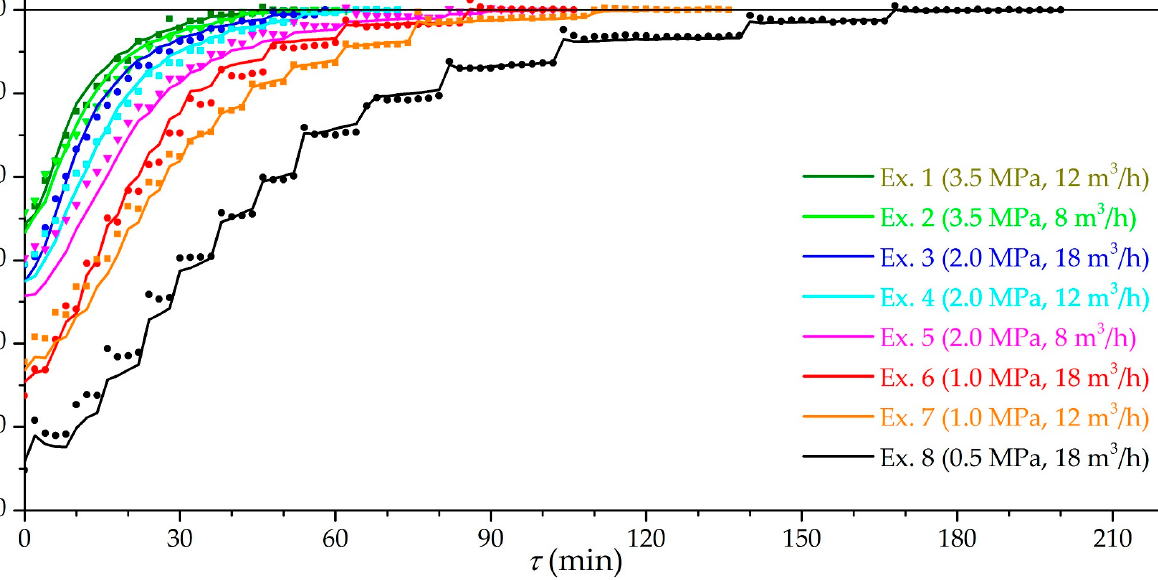
Figure 6. Time dependence of the relative effective charging capacity at different modes (the number of the experiment is indicated) at low-temperature charging (stage 2). Lines are theoretical values and dots are experimental values.